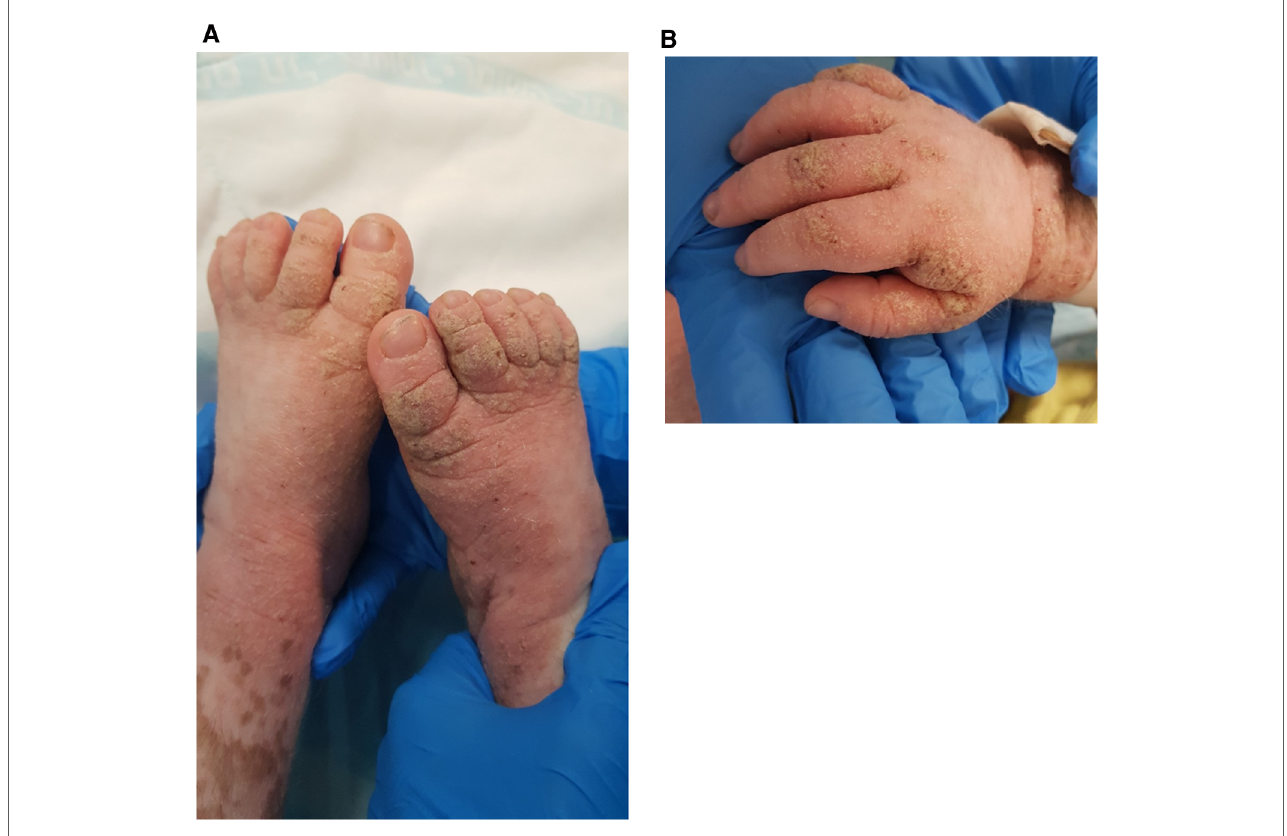
FIGURE 3 Erythematous plaques with diffuse yellow thick scale and hemorrhagic crusts on the feed ( A ) and hand ( B ) of a 3-year-old boy with MALT1 de fi ciency, consistent with Norwegian scabies.